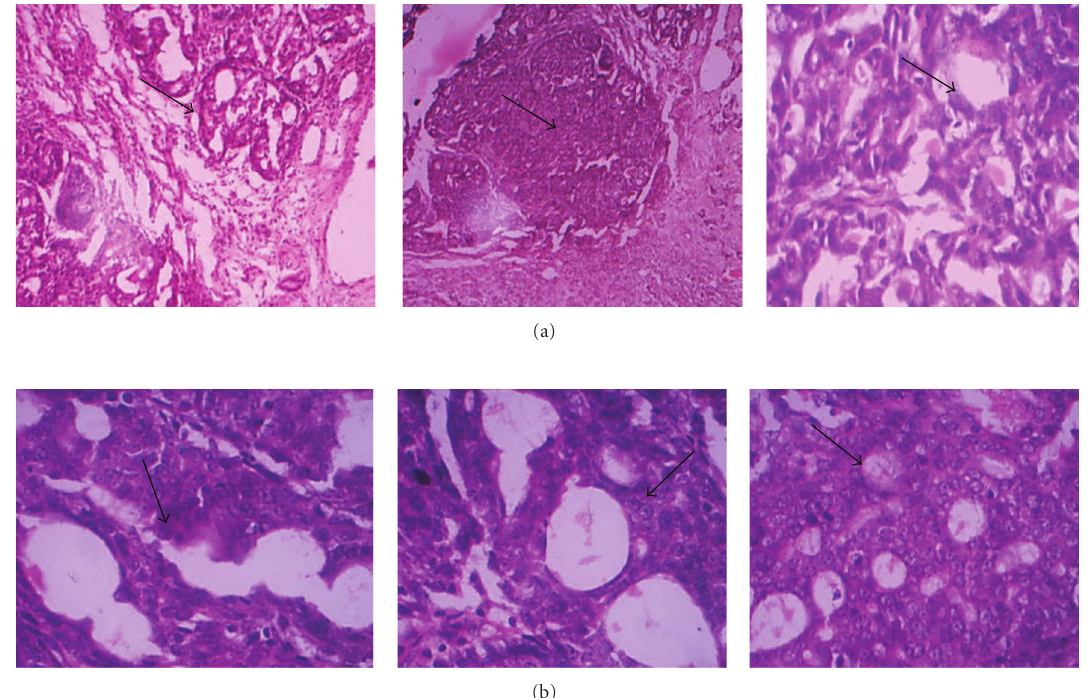
Figure 6: (a) Single rat with ductal carcinoma slides at di ff erent magnification. Arrow indicates ductal cells arranged in tubular pattern and tumor with 50% ductal di ff erentiation, (b) Single rat with metastasis stage carcinoma slides at di ff erent magnifications. Arrow indicates lymph node with metastasis